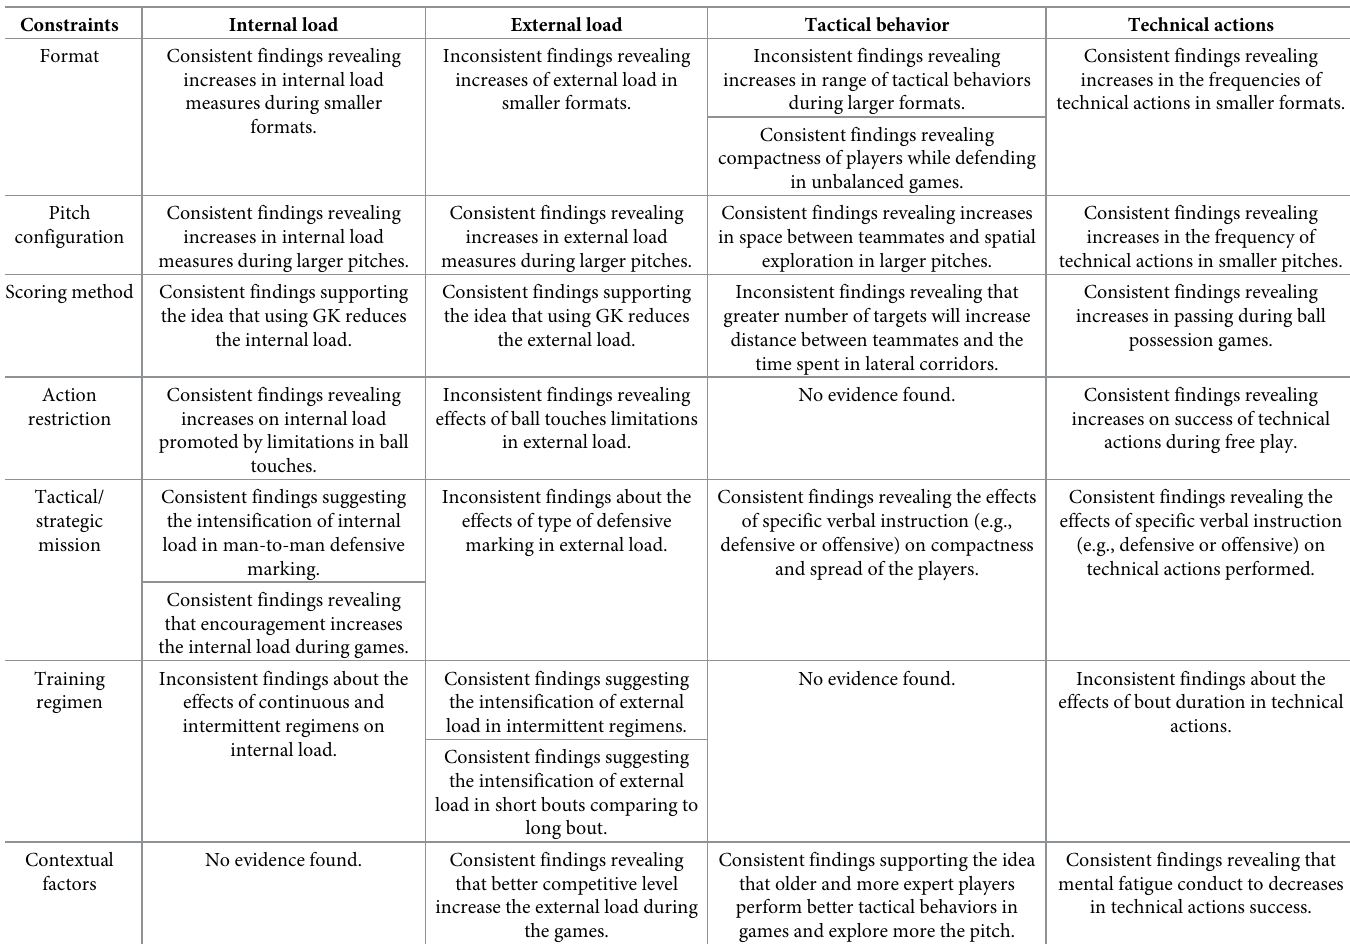
Table 3. Short-term, acute effects and adaptations of SSGs: Summary table.